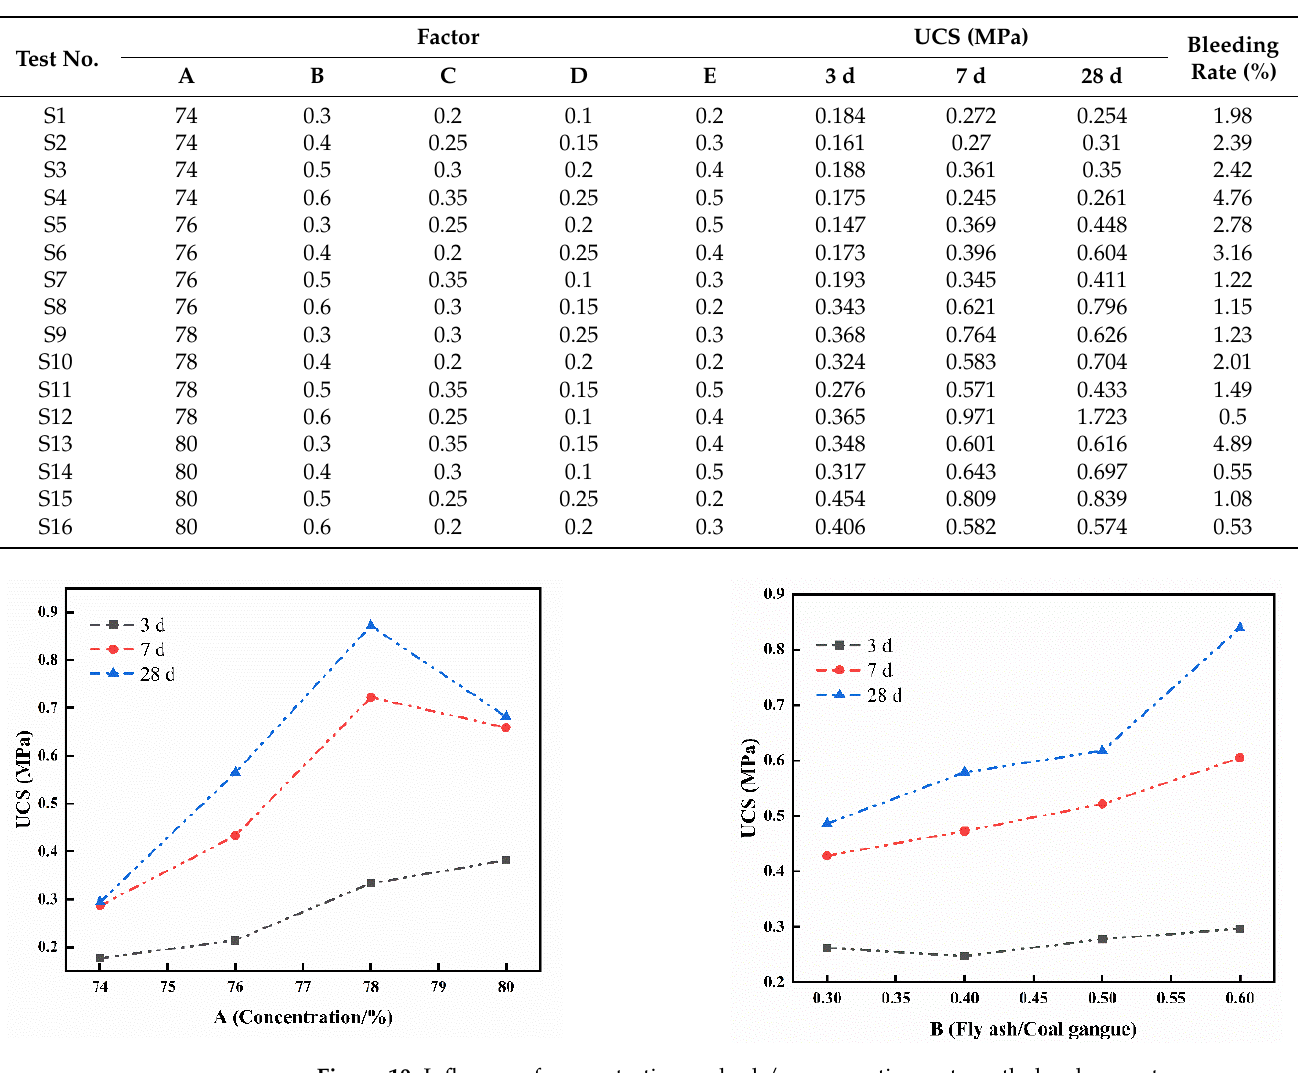
Figure 10. Influence of concentration and ash/gangue ratio on strength development.